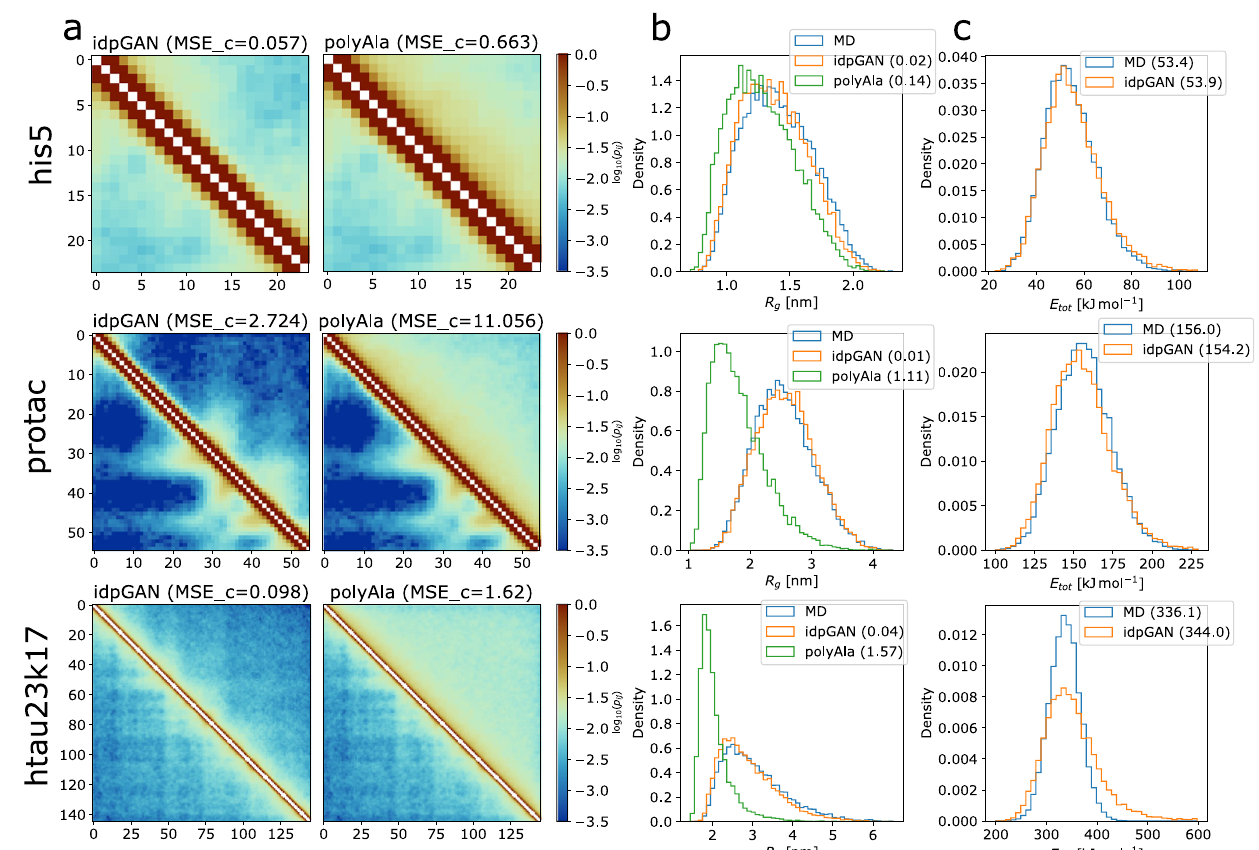
Fig. 2 | Examples from idpGAN for three IDP_test proteins. Each row of the image shows data for his5 ( L =24), protac ( L =55), and htau23k17 ( L =145), respectively. For each protein, the following information is reported: a idpGAN (left) and polyAla (right) contact maps are shown in the upper triangles of the images. The MD maps are shown in the lower triangles. The values shown along the horizontal and vertical axes are residue indices. Each cell of a map represents a residue pair and is colored according to its log( p ij ) value, where p ij is the